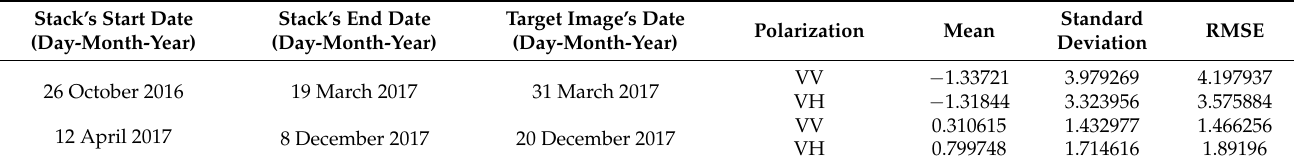
Figure 7. Images predicted by RNN LSTM (L1) and ConvLSTM (L2) models. Real observation corresponds to 31 March 2017. Table 2. Statistics of Delta images for Australia site.